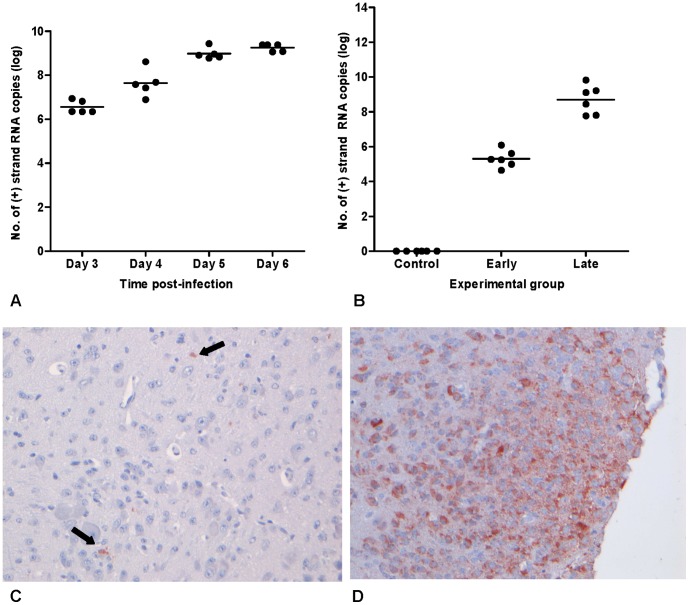
Detection of WNV in brains of mice infected with WNV-NY99.(A) The amount of WNV positive-sense RNA copies present in the brains of mice between days 3 and 6 post-infection with WNV-NY99. Mice were euthanized on day 3, 4, 5 and 6 post-infection and brains were collected and homogenized in DMEM for RNA isolation. (B) The amount of positive-sense RNA copies present in the brains of control mice and mice inoculated on days 3 and 5 post-infection. Brains were collected in RNA-later for RNA isolation using Trizol. Histopathology of the brains of 9-day old C57BL/6 mice infected with WNV-NY99. (C) Infected neurons in the brain of a mouse euthanized on day 3 p.i. (objective 20x). (D) Infected neurons in the cortex of a mouse euthanized on day 5 p.i. (objective 20x). Pictures are representative of the number of infected cells found in the brain for the majority of mice.